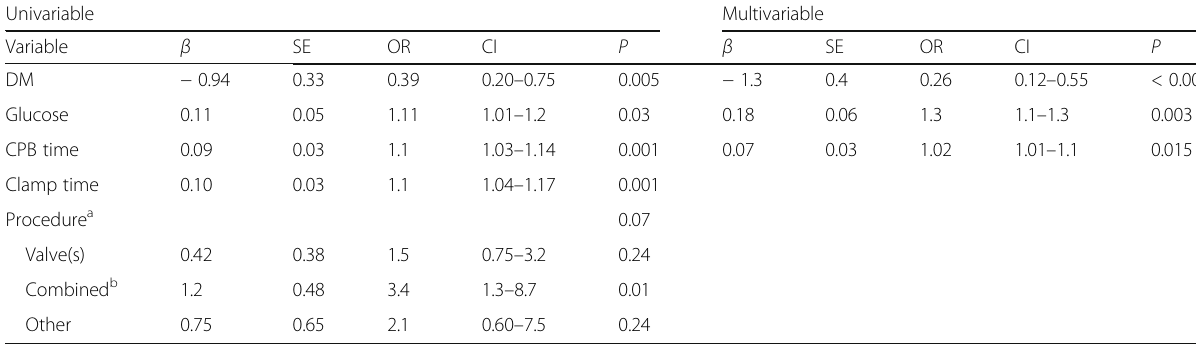
Table 3 Predictors of early hyperlactatemia with univariate and multivariable logistic regression a Univariable